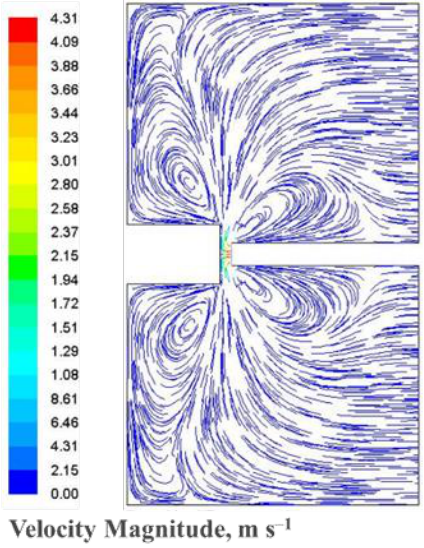
Figure 12. Calculated velocity path lines in the reactor at 150 A.